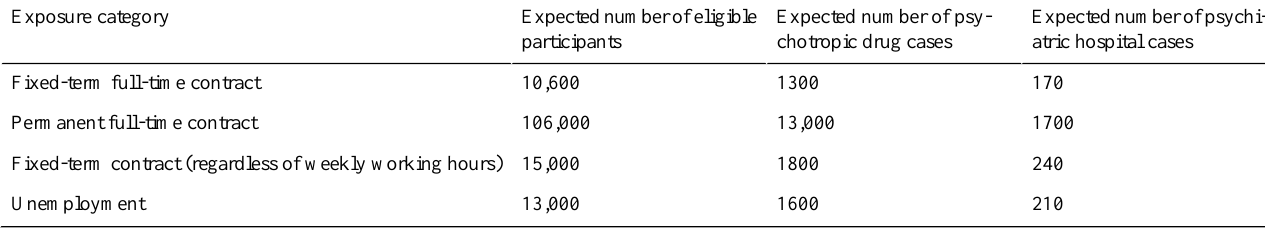
Table 4. The total number of expected cases in the concerned exposure